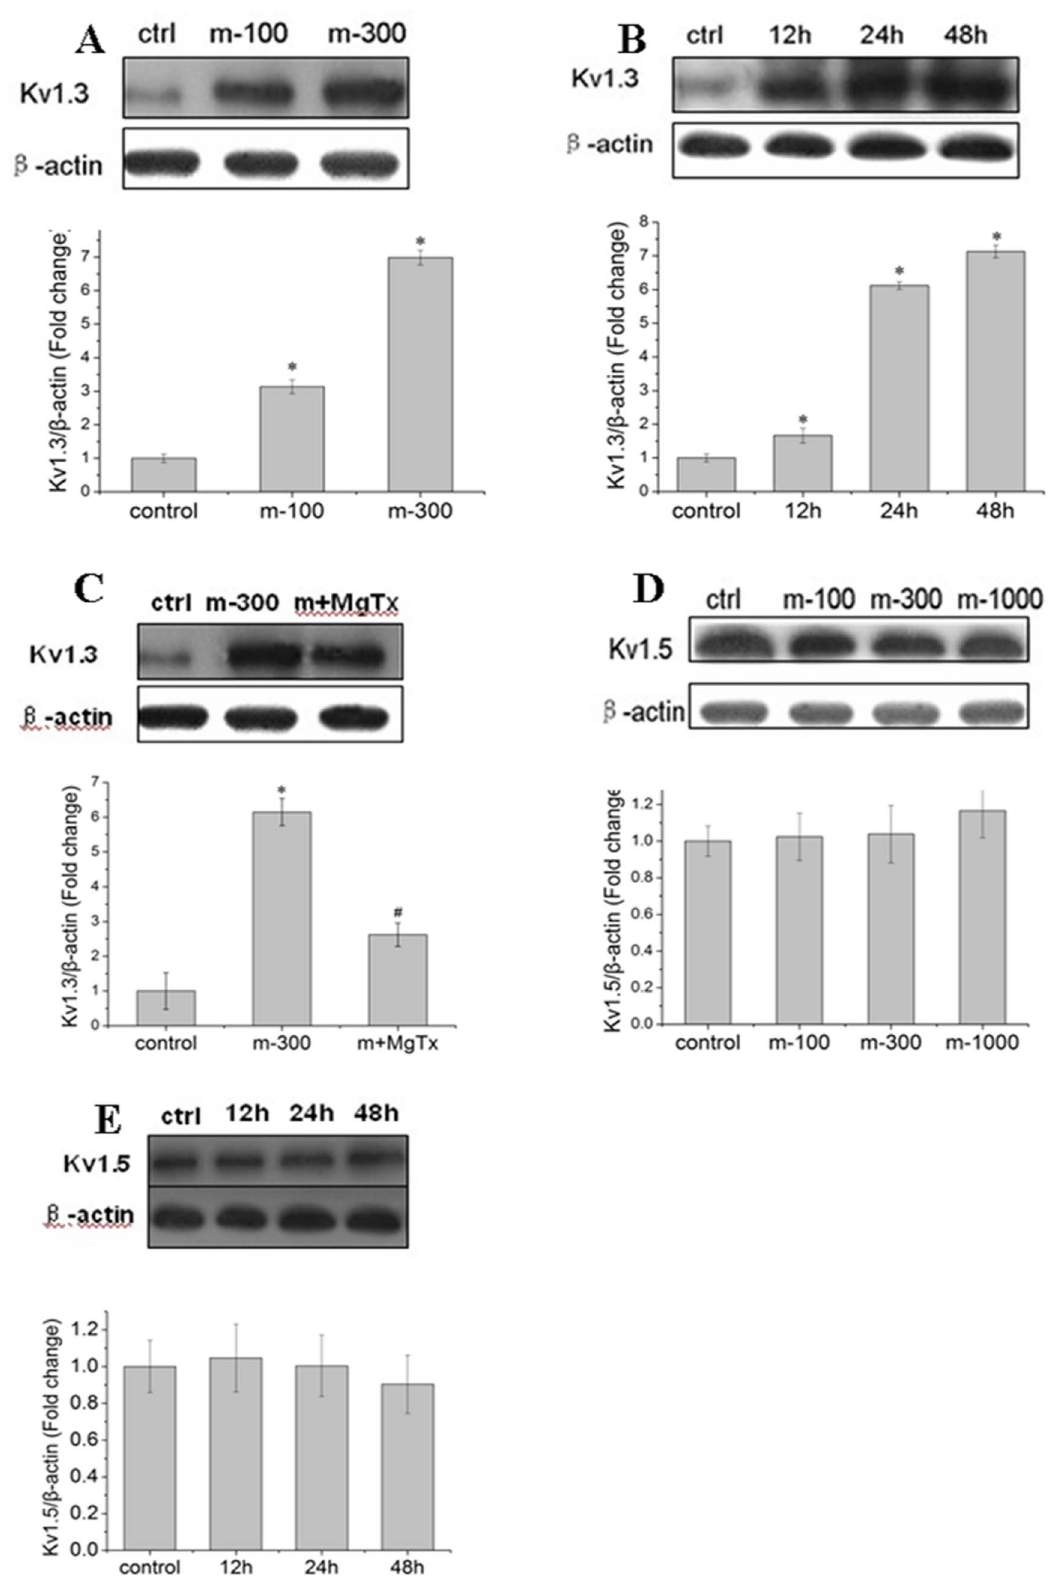
Figure 5. Meth increased Kv1.3 protein expression rather than Kv1.5. Microglial cells were incubated with Meth, and the level of Kv1.3, Kv1.5 proteins were detected by western-blot. (A) Meth (0, 100,300 m M) up-regulated Kv1.3 protein in a concentration dependent manner. (B) Meth (300 m M) obviously up-regulated Kv1.3 protein expression in 12, 24 and 48 h, and displayed a time-dependent way. (C) Meth mediated up-regulation